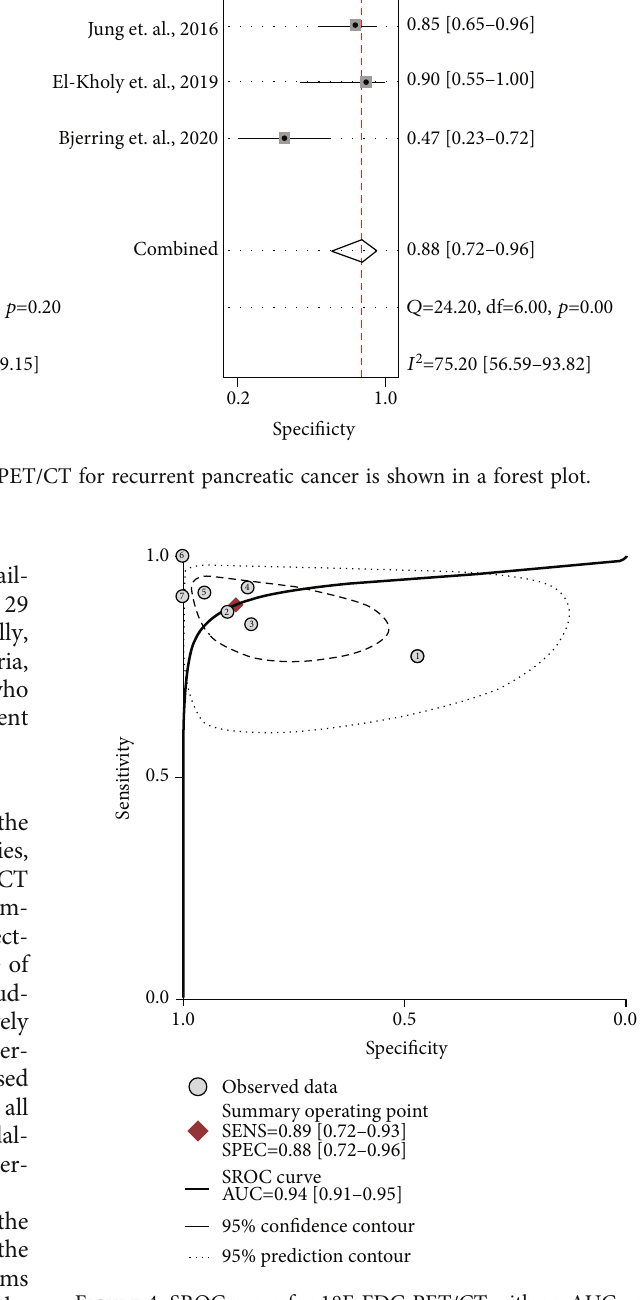
Figure 4: SROC curve for 18F-FDG PET/CT with an AUC